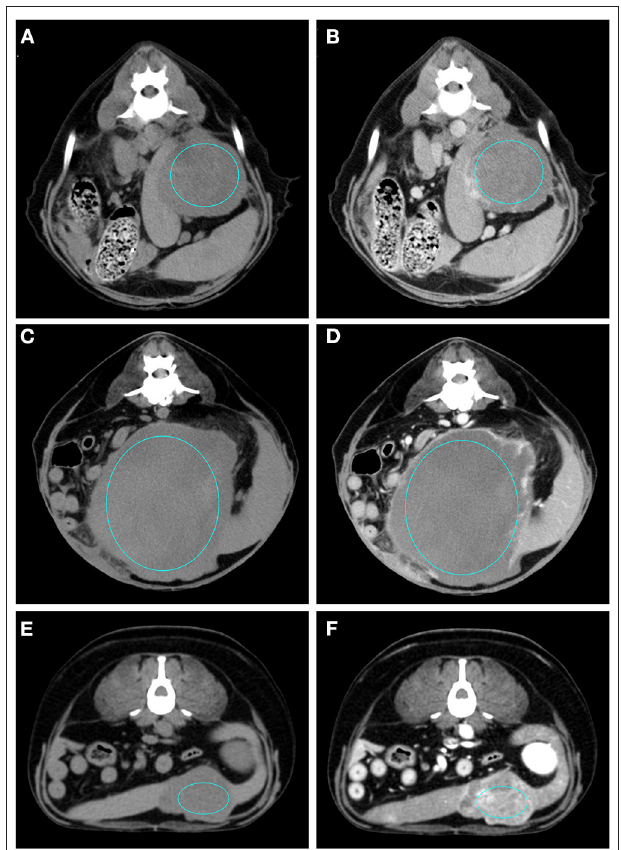
FIGURE 4 | Pre- (A) and post- (B) contrast images of a sarcoma (diagnosed as haemangiosarcoma) showing hypoattenuation and hypoenhancement, rim enhancement pattern with heterogeneous distribution, well-defined margins, irregular surface, and cyst-like appearance. Pre- (C) and post- (D) contrast images of a sarcoma (diagnosed as sarcoma) showing isoattenuation and hypoenhancement, diffuse enhancement pattern with heterogeneous distribution, well-defined margins, irregular surface, and cyst-like appearance. Pre- (E) and post- (F) contrast images of a sarcoma (diagnosed as stromal sarcoma) showing hypoattenuation and hyperenhancement, diffuse enhancement pattern with heterogeneous distribution, well-defined margins, irregular surface, and cyst-like appearance. The ROI is placed inside the